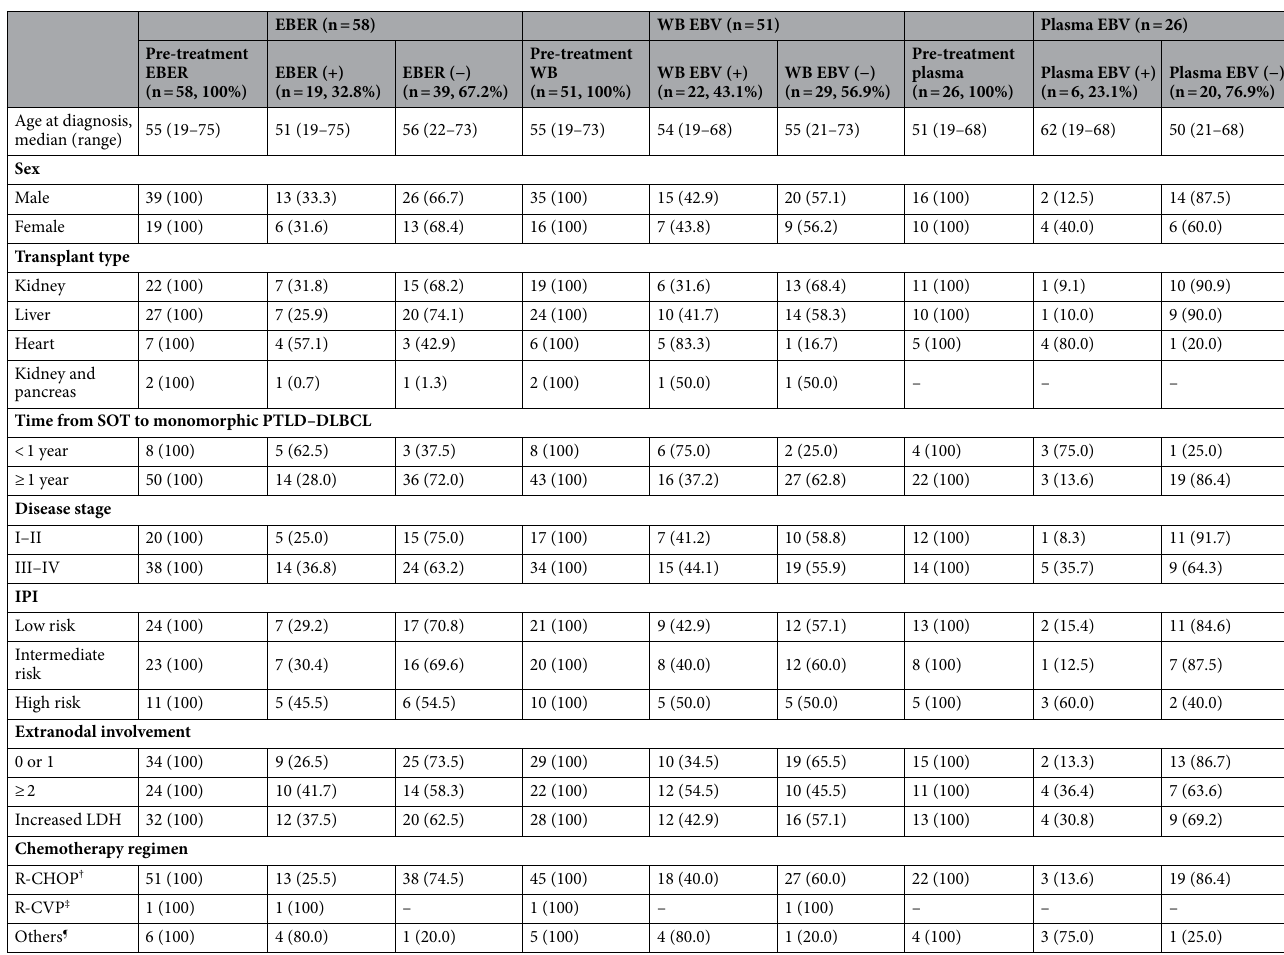
Table 1. Baseline characteristics of the patients according to the pre-treatment EBER, whole blood EBV, and plasma EBV status. † Four patients were treated with CHOP. ‡ One patient was treated with R-CVP due to a cardiac problem. ¶ Ifosfamide, carboplatin, etoposide, and dexamethasone (ICE-Dexa) (n = 1), bendamustine and rituximab (BR) (n = 3), high dose of methotrexate and cytarabine (HD-MTX plus Ara-C) (n = 1), and no chemotherapy (n = 1); one patient underwent ileal & rectal resection. PTLD post-transplantation proliferative disorder, DLBCL diffuse large B-cell lymphoma, SOT solid organ transplant, EBV Epstein-Barr virus, EBER Epstein-Barr virus-encoded small ribonucleic acids, WB whole blood, IPI international prognostic index, LDH lactate dehydrogenase, R-CHOP rituximab plus cyclophosphamide, doxorubicin, vincristine, and prednisone, R-CVP rituximab plus cyclophosphamide, vincristine, and